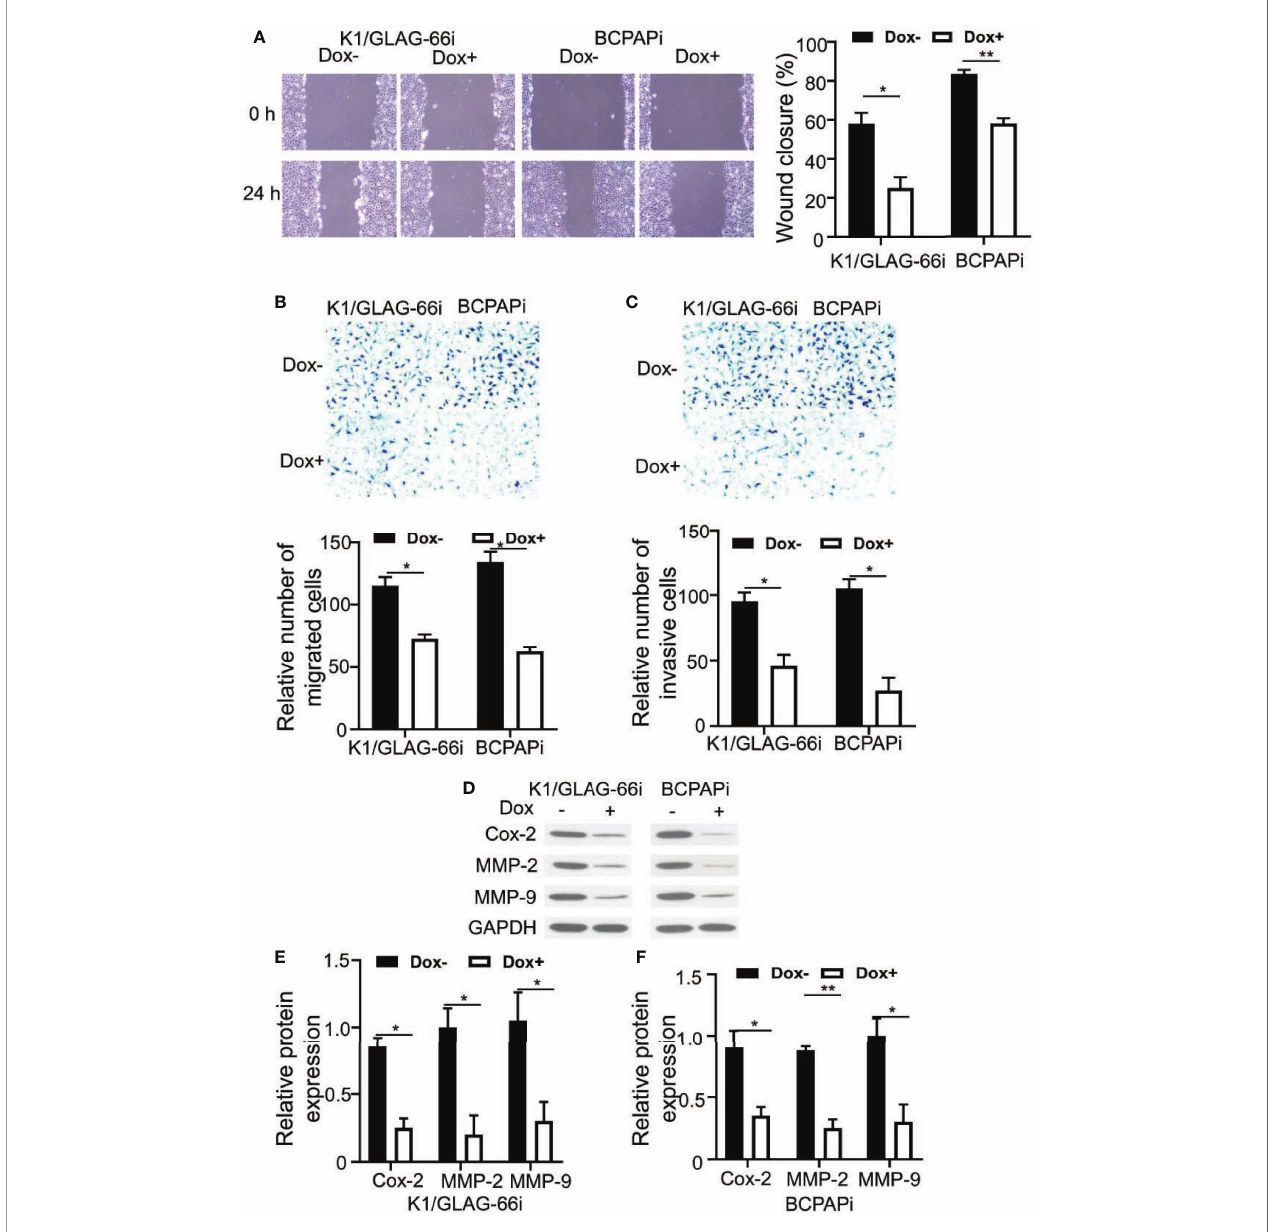
FIGURE 2 | ZNF24 inhibited K1/GLAG-66i and BCPAPi cells migration and invasion. (A – C) Cell migration and invasion detection by Wound Healing test (A) and transwell chamber assay (B, C) of K1/GLAG-66i and BCPAPi cells treated without or with DOX (1 µg/ml); (D) Cell migration and invasion protein makers expression level detection by Western Blot assay of K1/GLAG-66i and BCPAPi cells treated without or with DOX (1 µg/ml), indicated antibodies were added during Western Blot assay; (E, F) Statistical analysis of cell migration and invasion protein makers expression level based on western blot assay result Values are obtained from 3 independent assays, while unpaired t-test was used for analysis. Error bars= SD. *P < 0.05; **P <